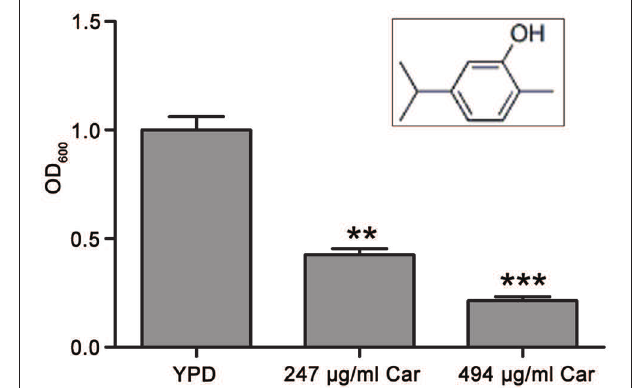
FIGURE 1 | Chemical structure of carvacrol and its effect on C. albicans survival. The chemical structure of carvacrol was exhibited, and the effect of carvacrol on C. albicans survival was analyzed by determining CFUs. Data were shown as mean ± SD ( n = 5). Significant difference was designated as ** P < 0.01 and *** P <